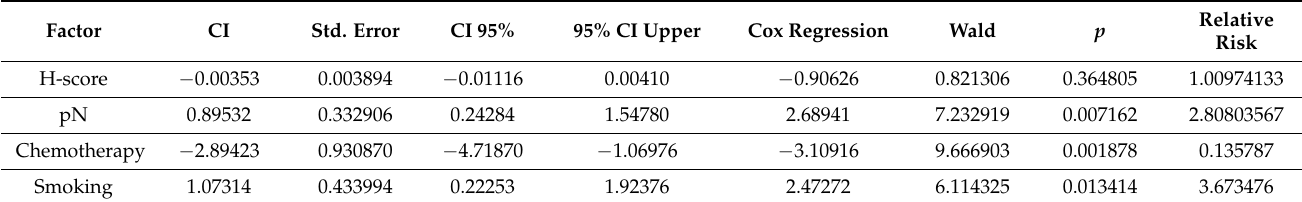
Figure 4. Overall survival analysis according to ZNF-281 level of: ( A ) H-score—patients with positive H-score (>50, n = 42) vs. negative H-score (<50, n = 24), log-rank p = 0.77; and ( B ) mRNA—patients were divided according to mean ± SD into three groups: low (<0.50, n = 26), medium (0.50 < x < 1.22, n = 12) and high (>1.22, n = 10), log-rank p = 0.55. Table 3. Multiple Cox regression model for group of 66 patients: significant predictors of hazard and non-significant ZNF-281 H-score. Analysis of impact on OS of ZNF-281 H-score with adjustments for all clinical factors.